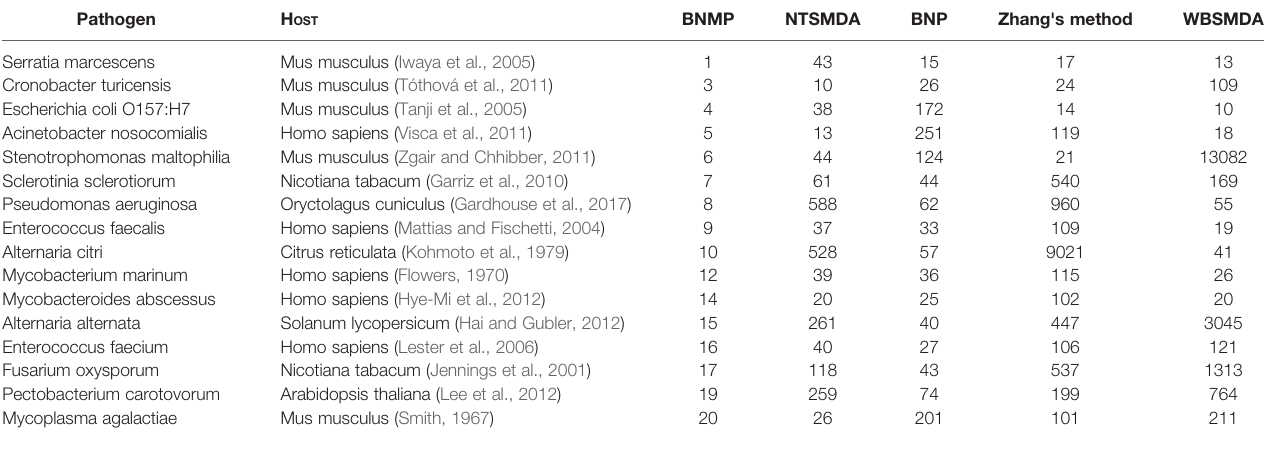
TABLE 2 | Pathogen – host pairs predicted using BNMP and their rank according to fi ve methods. Pathogen H